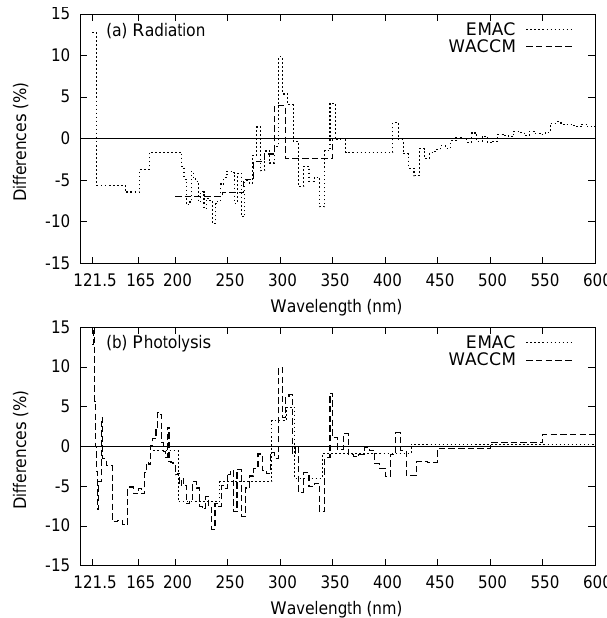
Figure 7. CMIP6 SSI differences of the solar irradiance (%) for per- petual solar-minimum conditions compared to CMIP5(NRLSSI1) (a) in the spectral resolution of the radiation schemes and (b) in the spectral resolution of the photolysis schemes of EMAC (short- dashed) and CESM1(WACCM)